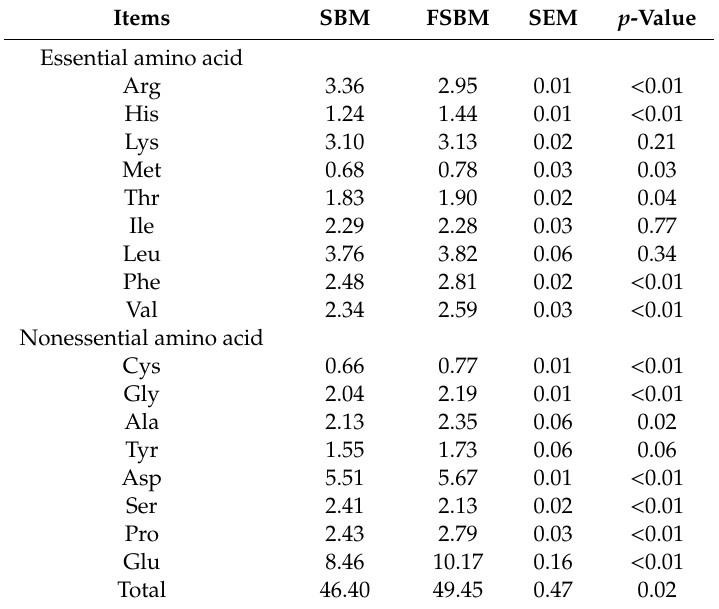
Table 4. Amino acid composition of SBM fermented for 24 h with B. amyloliquefaciens.